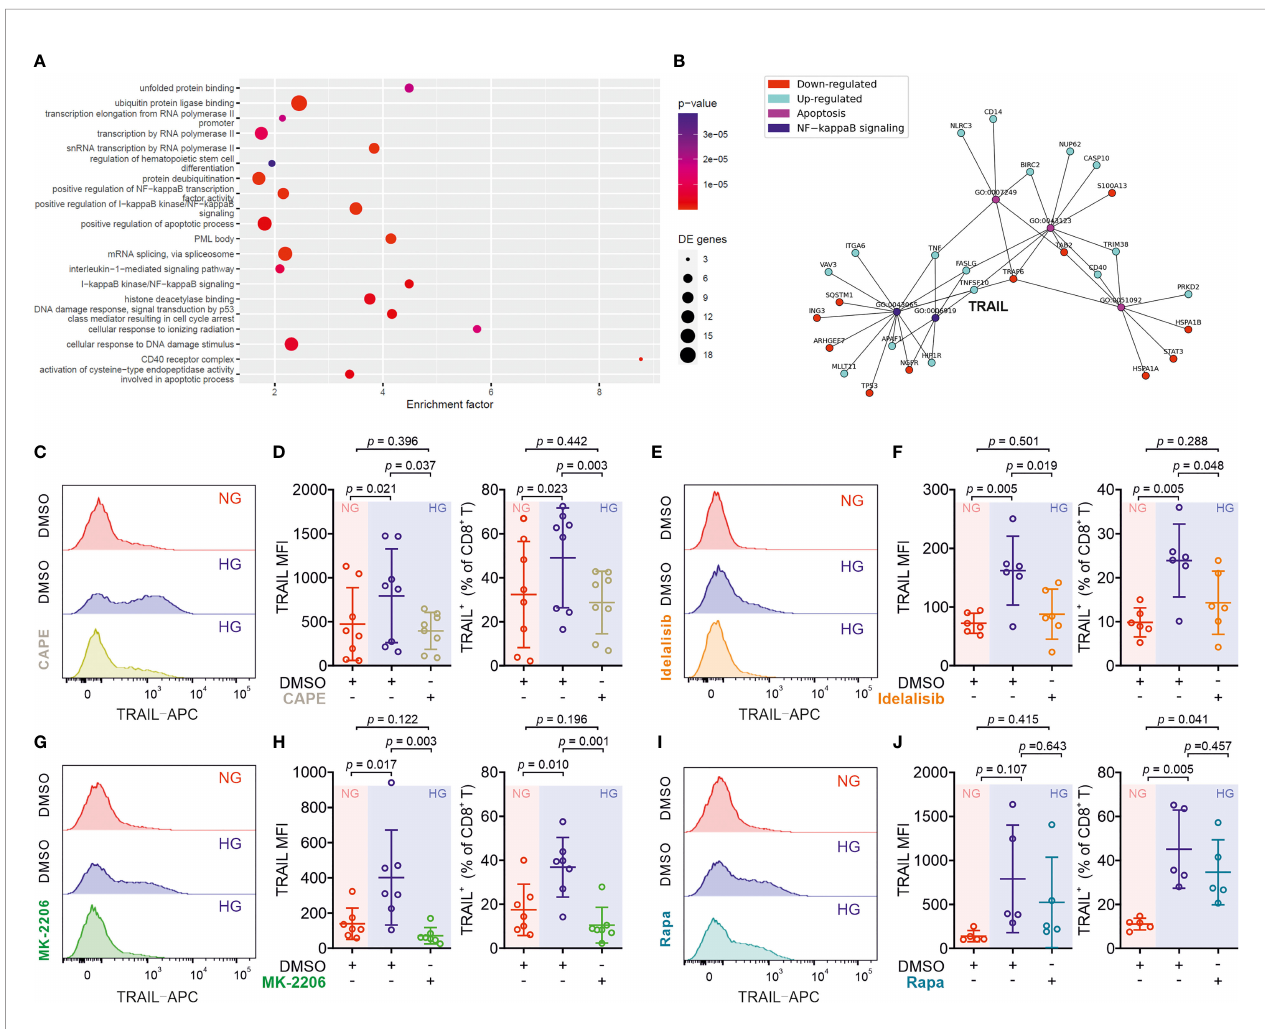
FIGURE 4 | Up-regulation of TRAIL in CTLs is regulated by the PI3K/Akt/NF k B axis. (A) Enriched KEGG pathways for the comparison between HG and NG conditions. (B) Ten most signi fi cantly enriched/depleted Gene ontology terms in HG vs NG conditions. Enrichment analysis was performed with the path fi ndR package, which creates a sub-network of the human protein-protein interaction network that only contains genes with signi fi cant differential expression. The enrichment factor of an annotation is calculated as the fraction of proteins having this annotation in the sub-network, relative to the entire network. (C – J) Primary human CD8 + T cells were stimulated with CD3/CD28 beads for 3 days in presence or absence of NF- k B speci fi c inhibitor CAPE ( C, D , 5 m M, n = 8 donors from three independent experiments), PI3K inhibitor Idelalisib ( E , F , 300 nM, n = 6 donors from three independent experiments), Akt inhibitor MK-2206 ( G, H , 200 nM, n = 7 donors from four independent experiments), or mTOR inhibitor Rapamycin ( I, J, 600 nM, n = 5 donors from three independent experiments). CD8 + T cells were stained with antibody against CD8 and TRAIL and were analyzed by fl ow cytometry. Representative donors are shown in (C, E, G, I) . Data are represented as Mean ± SD and p values were assessed by one-way ANOVA with Bonferroni ’ s multiple comparison